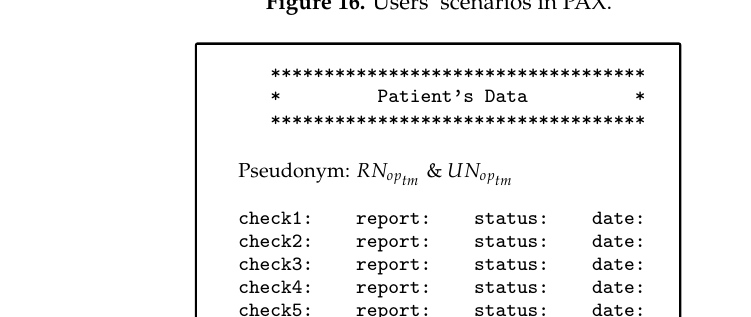
Figure 15. Users’ scenarios in PAX. Figure 16. Users’ scenarios in PAX.